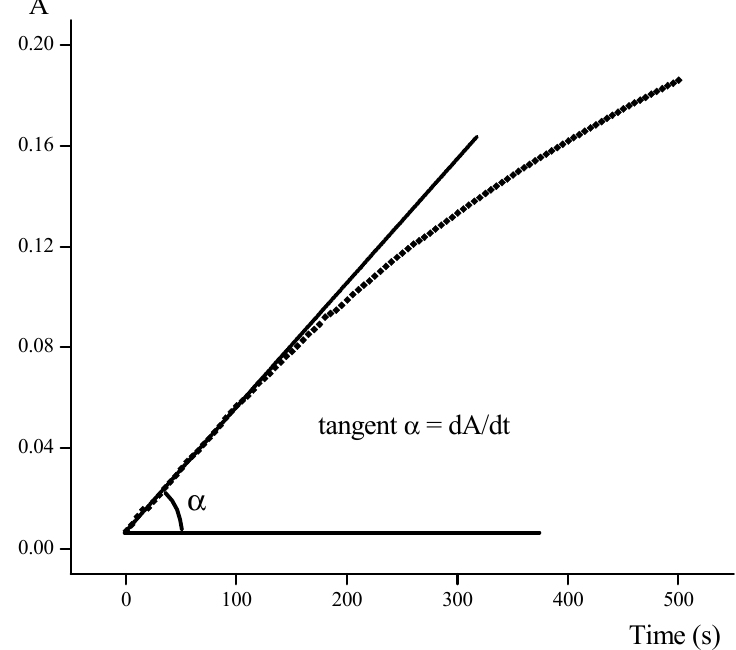
Figure 2. Example of a determination of the initial synthesis reaction rate dA/dt for the complex FeOx 3 (BCH 3 ) 2 ( 5 ) at [Fe 2+ ] = 2 × 10 − 5 mol L − 1 , [H 2 Ox] = 1.5 × 10 − 3 mol L − 1 , [CH 3 B(OH) 2 ] = 5 × 10 − 3 mol L − 1 and pH = 3.75.